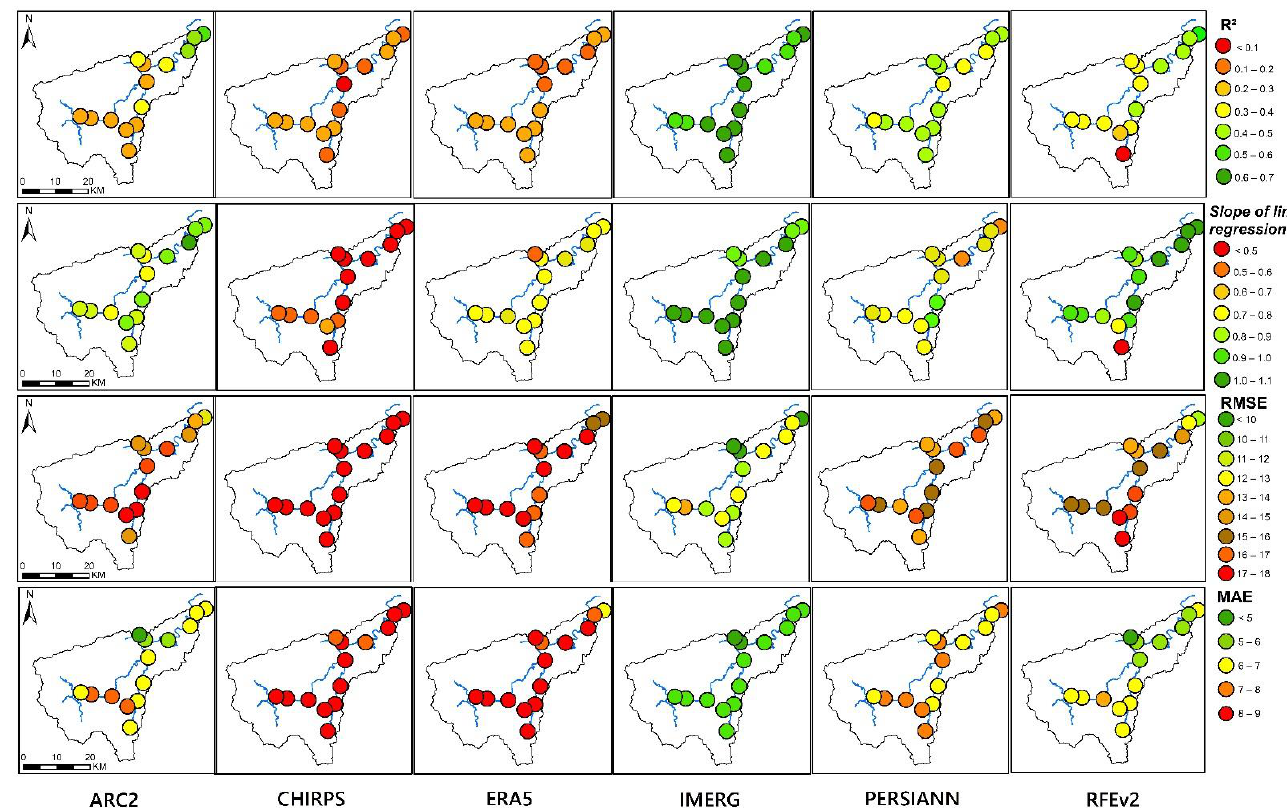
Figure 4. Spatial distribution of the statistical evaluation metrics across the Ankavia watershed based on the point-gridded approach at a daily time scale from September 2018 to August 2020.